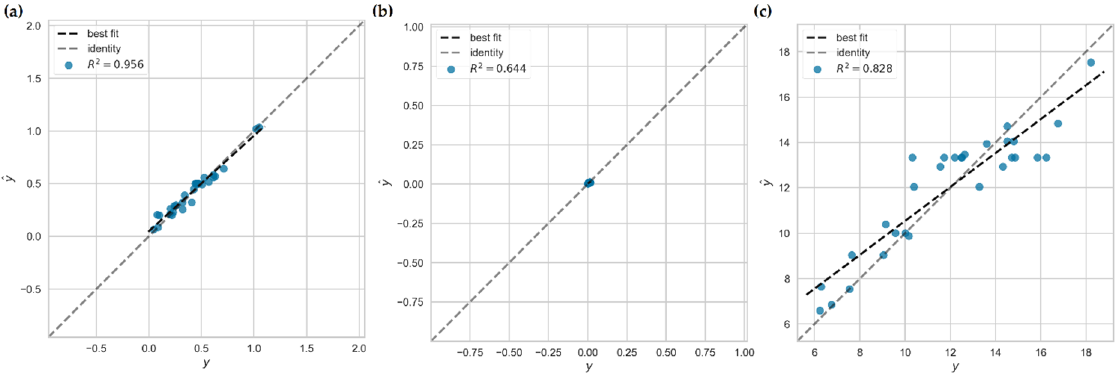
Figure 6. Experimental versus AdaBoost regression predicted ( a ) MRR ( b ) EWR ( c ) SR.